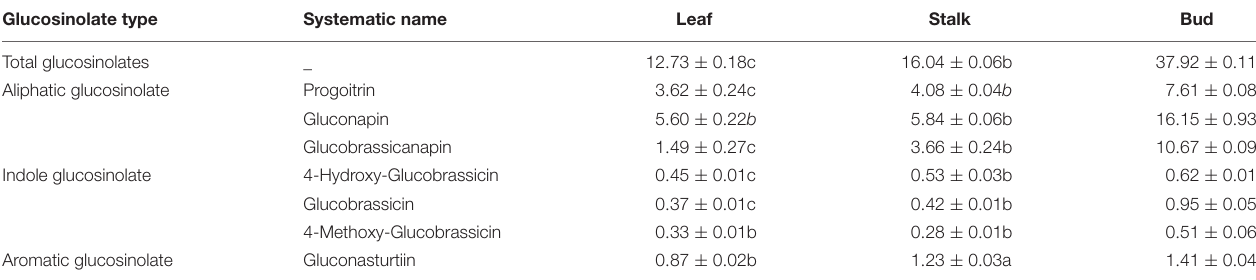
TABLE 1 | Composition and content ( µ mol/100 g) of glucosinolates in different parts of Chinese flowering cabbage. Glucosinolate